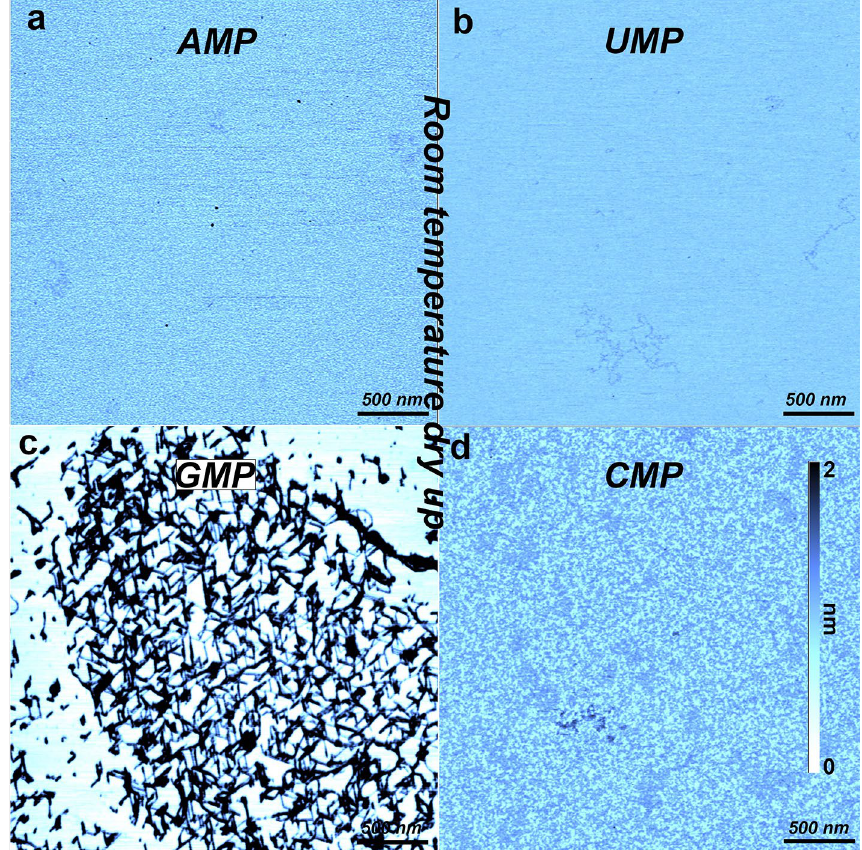
Figure 1. AFM images of 10 mM solutions of mononucleotides dried on mica surfaces. ( a ) Adenosine monophosphate (AMP), ( b ) Uridine monophosphate (UMP), ( c ) Guanosine monophosphate (GMP) The concentrated GMP forms quadruplex structures that stack into long rods which become aligned with the crystalline surface of the mica. ( d ) Cytidine monophosphate (CMP). To make the images comparable the color scale covers the range from 0 to 2 nm for all